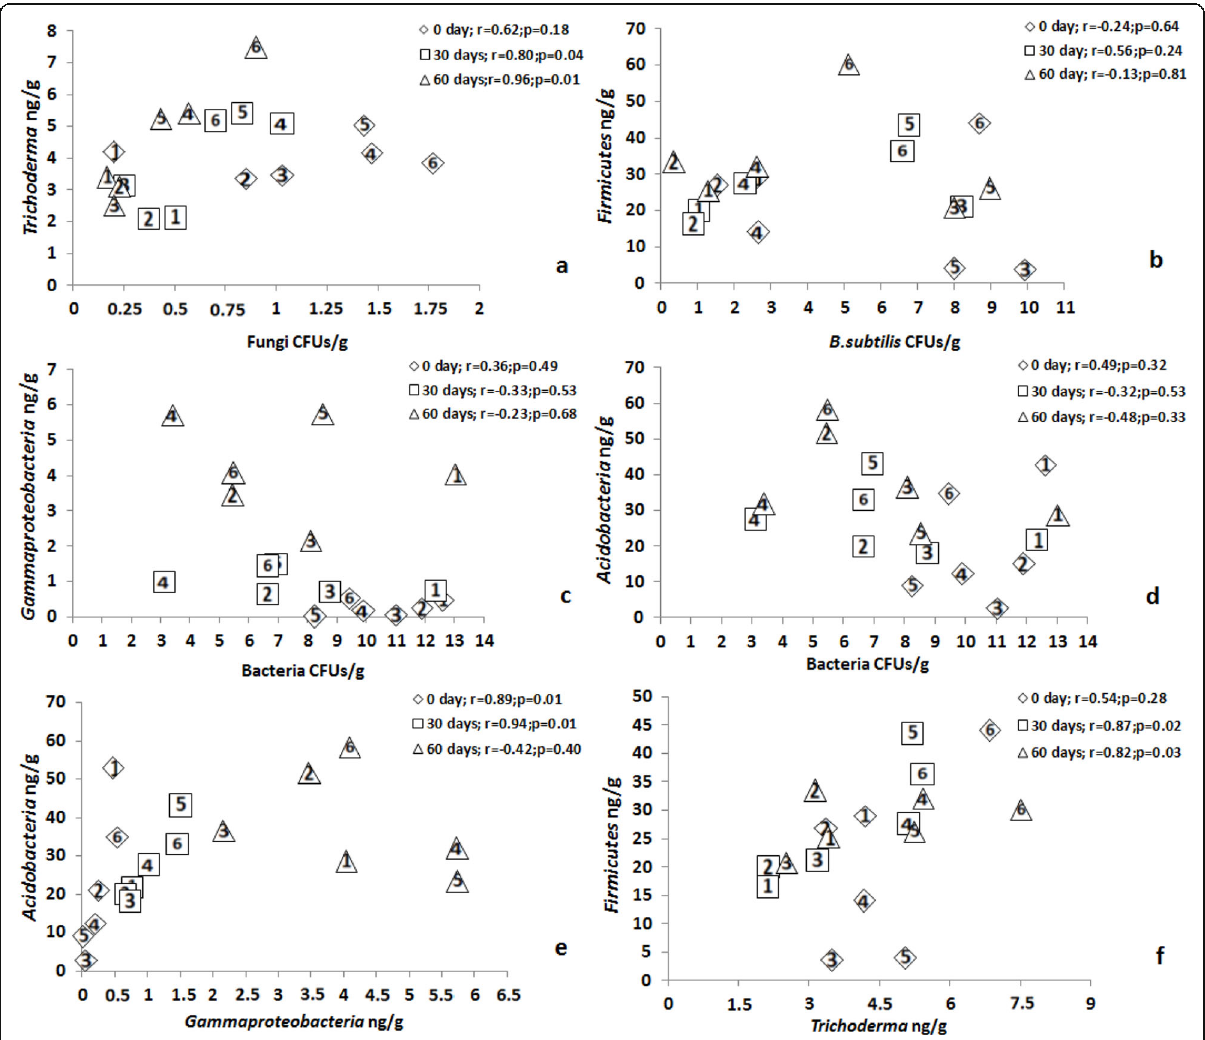
Fig. 4 Pearson correlation analysis between microbiological and molecular analysis data. Treatment of experimental soil samples: (1) control, (2) Botrytis cinerea , (3) Bacillus subtilis , (4) Trichoderma asperellum , (5) B. subtilis + T .asperellum and (6) B. subtilis + T. asperellum + B. cinerea . Pearson correlation coefficient and the significance of correlation are indicated. Correlation between fungal CFUs/g and amplicons of Trichoderma ng/g ( a ), between B. subtilis CFUs/g and Firmicutes ng/g ( b ), between bacterial CFUs/g and Gammaproteobacteria amplicons ng/g ( c ), between bacterial CFUs/g F and Acidobacteria amplicons ng/g ( d ), between Acidobacteria and Gammaproteobacteria amplicons ng/g ( e ) and between Trichoderma and Firmicutes amplicons ng/g ( f